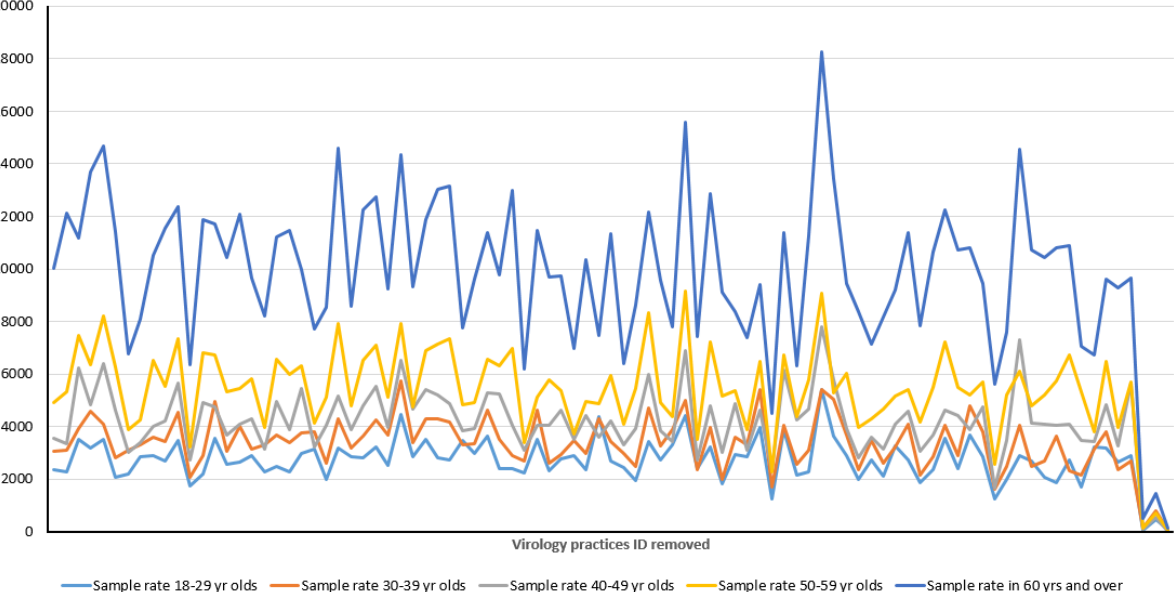
Figure 9. Variation of blood sampling in adults according to age. Rate of full blood count sampling per 100,000 registered patients for each adult age group, per year, by individual virology practice. Practice unique identifiers have been